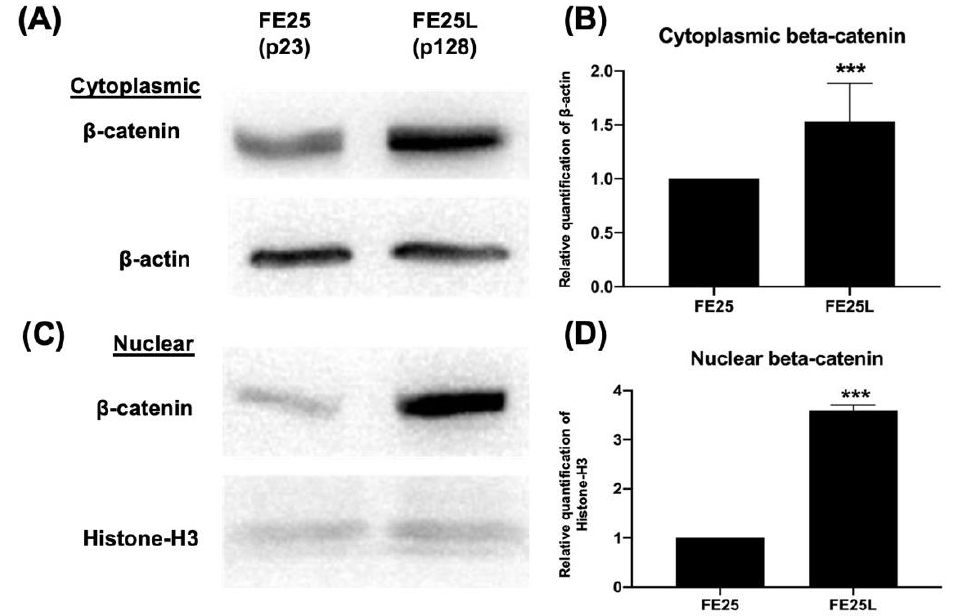
Figure 8. Beta-catenin gene and protein expression in FE25 (p23) and FE25L (p128) cells. ( A ) Western blot analysis of beta-catenin protein expression in the cytoplasm of FE25 and FE25L cells. ( B ) Quantification of beta-catenin expression in ( A ) ( n = 3 in each group). ( C ) Western blot analysis of beta-catenin expression in the nuclei of FE25 and FE25L cells. ( D ) Quantification of beta-catenin expression in ( C ) ( n = 3 in each group). *** p < 0.001.